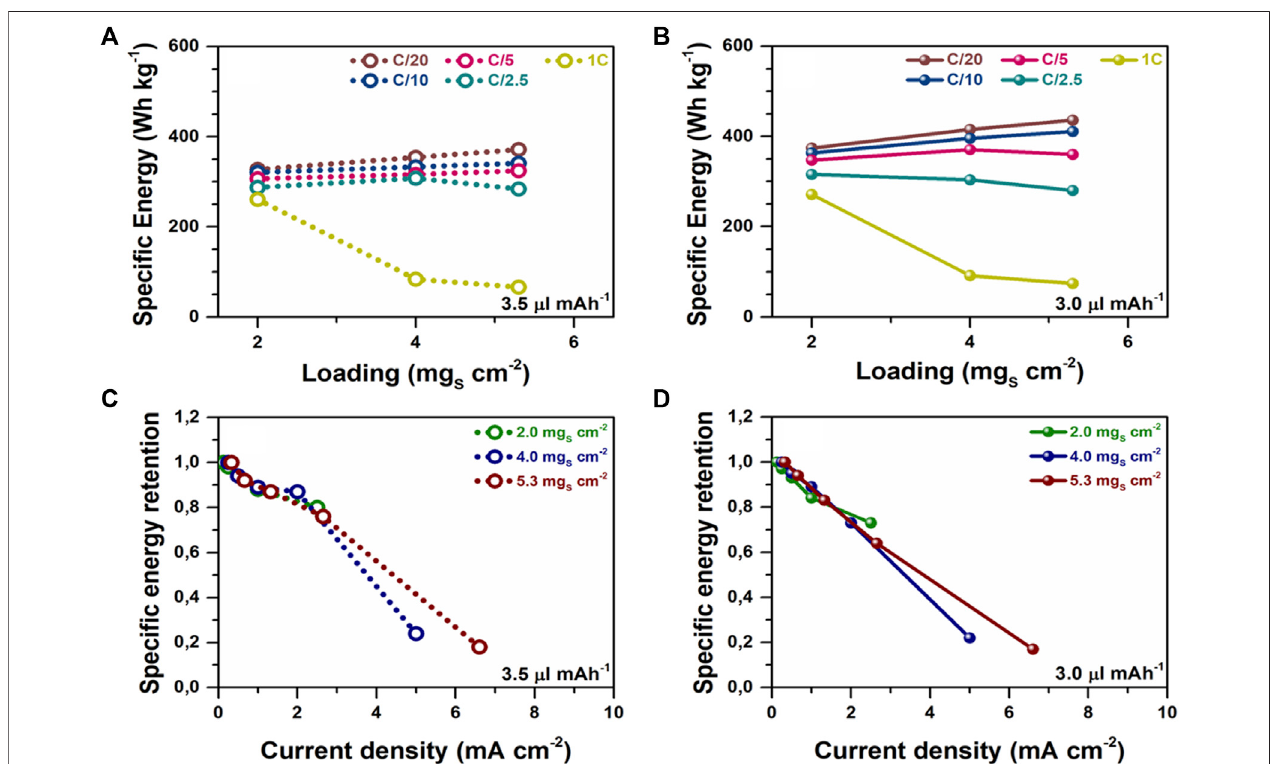
FIGURE 6 | Discharge C-rate performance of Li-S pouch-cells with different ASL (2.0, 4.0, and 5.3 mg s cm − 2 ): Speci fi c energy densities of cells with (A) E/C 3.5 µl mAh − 1 and (B) E/C3.0 µl mAh − 1 .Dischargeenergyretentionversuscurrentdensityofcellswith (C) E/C3.5 µl mAh − 1 (D) andE/C3.0 µl mAh − 1 .NOTE:Tabsand packaging were excluded from the speci fi c energy